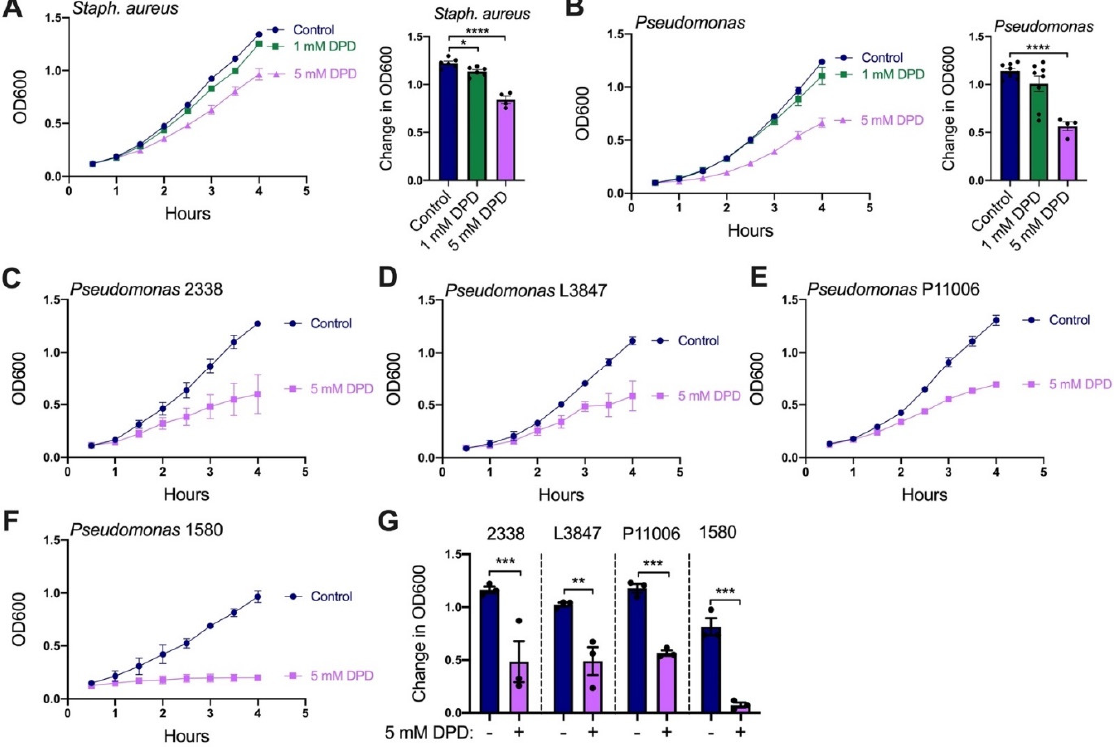
Figure 6. Diphenhydramine represses the planktonic growth of S. aureus and P. aeruginosa . ( A